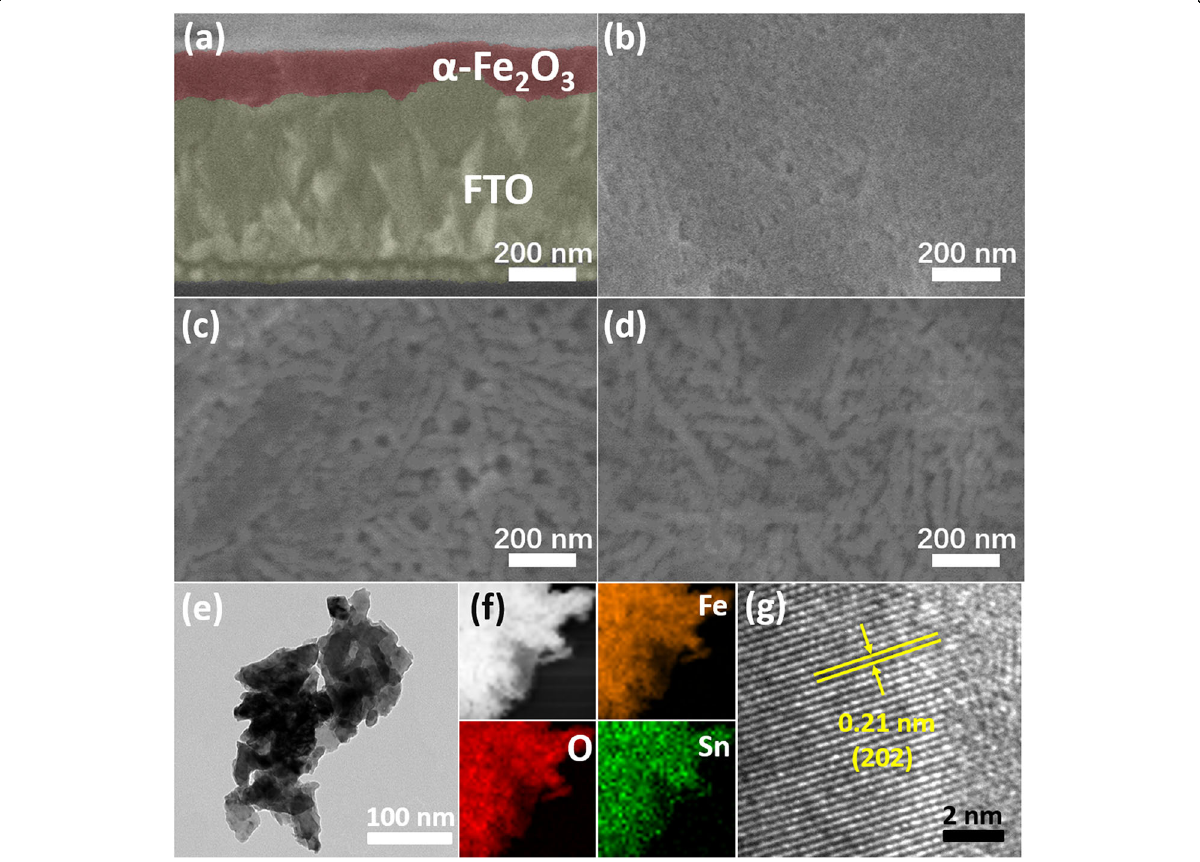
Fig. 1 Representative SEM and TEM photos of the synthesized α -Fe 2 O 3 film. a , b The cross-sectional and top-view SEM images of the sample with 0% doping and no-RTP. c The top-view SEM image of the 15% Sn-doped sample. d The top-view image of the 15% Sn-doped hematite with post-RTP. e TEM image of Sn-doped hematite with post-RTP. f STEM image of partial region in e . g HRTEM image of the Sn-doped α -Fe 2 O 3 with